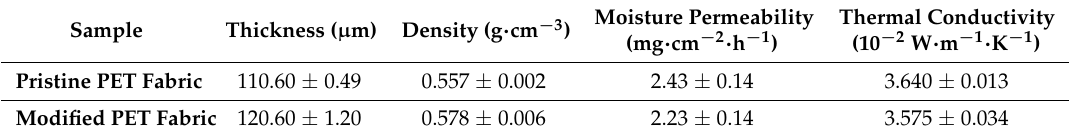
Table 1. Comparison of the physical properties of PET fabrics before and after modification by the BF